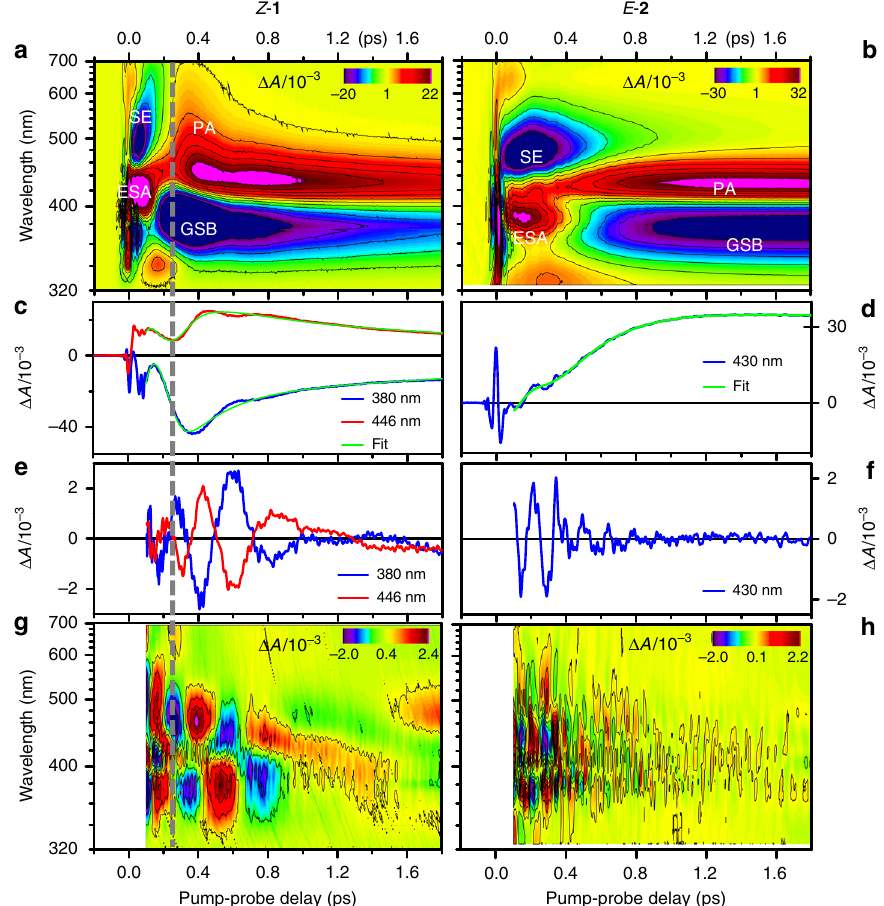
Fig. 2 Transient absorption spectroscopy of Z- 1 and E- 2 upon resonant excitation. a , b 2D map representations of the differential absorption ( Δ A ) coded in false colors, as a function of probing wavelength (nm) and pump-probe time delay (ps). The TA data are obtained upon excitation with a resonant, 8.5 fs pump pulse of a methanol solution of Z - 1 (left column) and E - 2 (right column). c Kinetic traces illustrating the signal detected at the 380 nm (blue trace) and 446 nm (red trace) probe wavelengths for Z- 1 , and the result of the 2D map global fi t (green) at the same wavelengths. d Same for E- 2 , at the 430 nm probing wavelength. e , f The corresponding residuals reveal the oscillatory signatures of the nuclear motions. g , h 2D map representation of the residuals of the global fi t of both TA data sets. Time delays shorter than 0.1 ps are disregarded (see Methods section). Fourier transformation of these maps along the time axis reveals the power spectra of the oscillatory signals, interpreted as vibrational spectra (Fig. 3). The vertical dashed line at 250 fs across a , c , e , g indicates the moment of impulsive S 1 decay of 1 at the